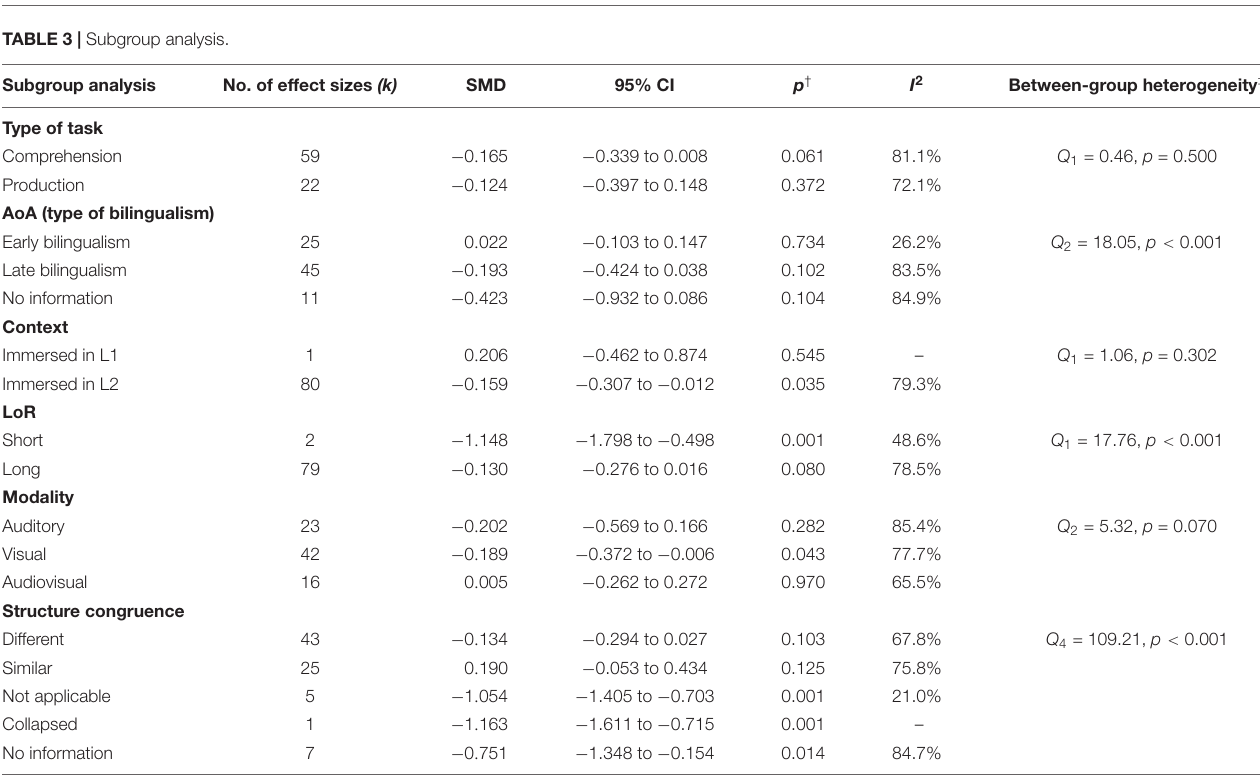
TABLE 3 | Subgroup